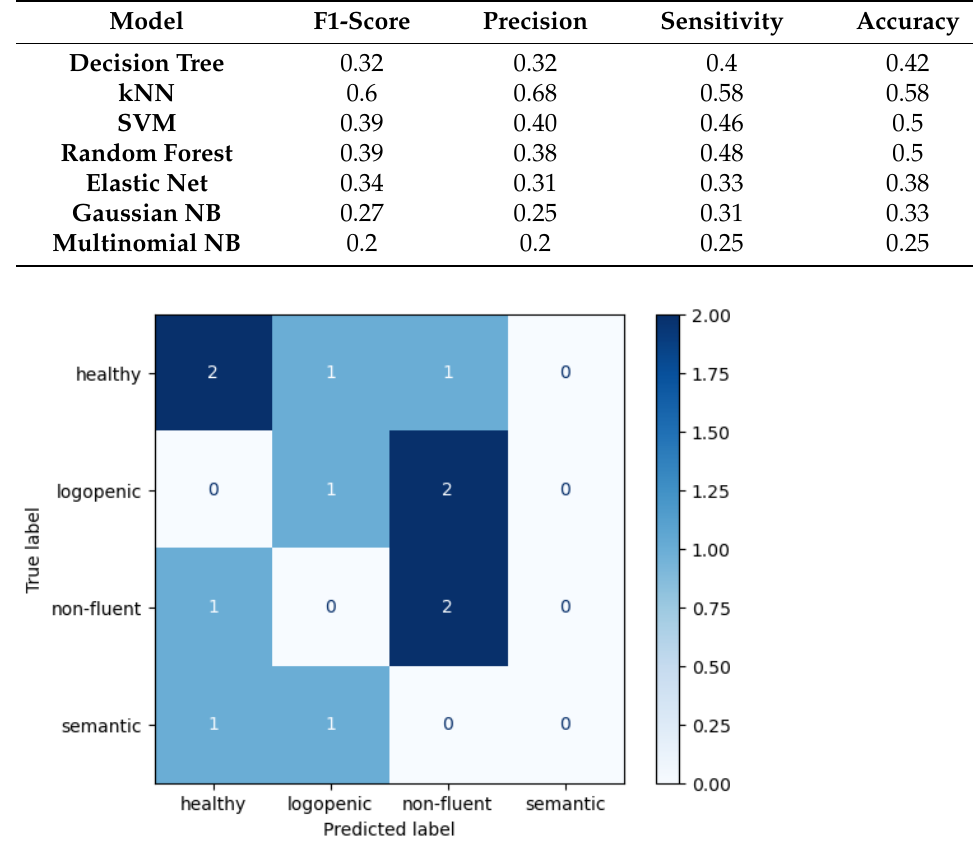
Table 3. Metrics from classification models for 4 groups (nfvPPA, svPPA, lvPPA, and CG).